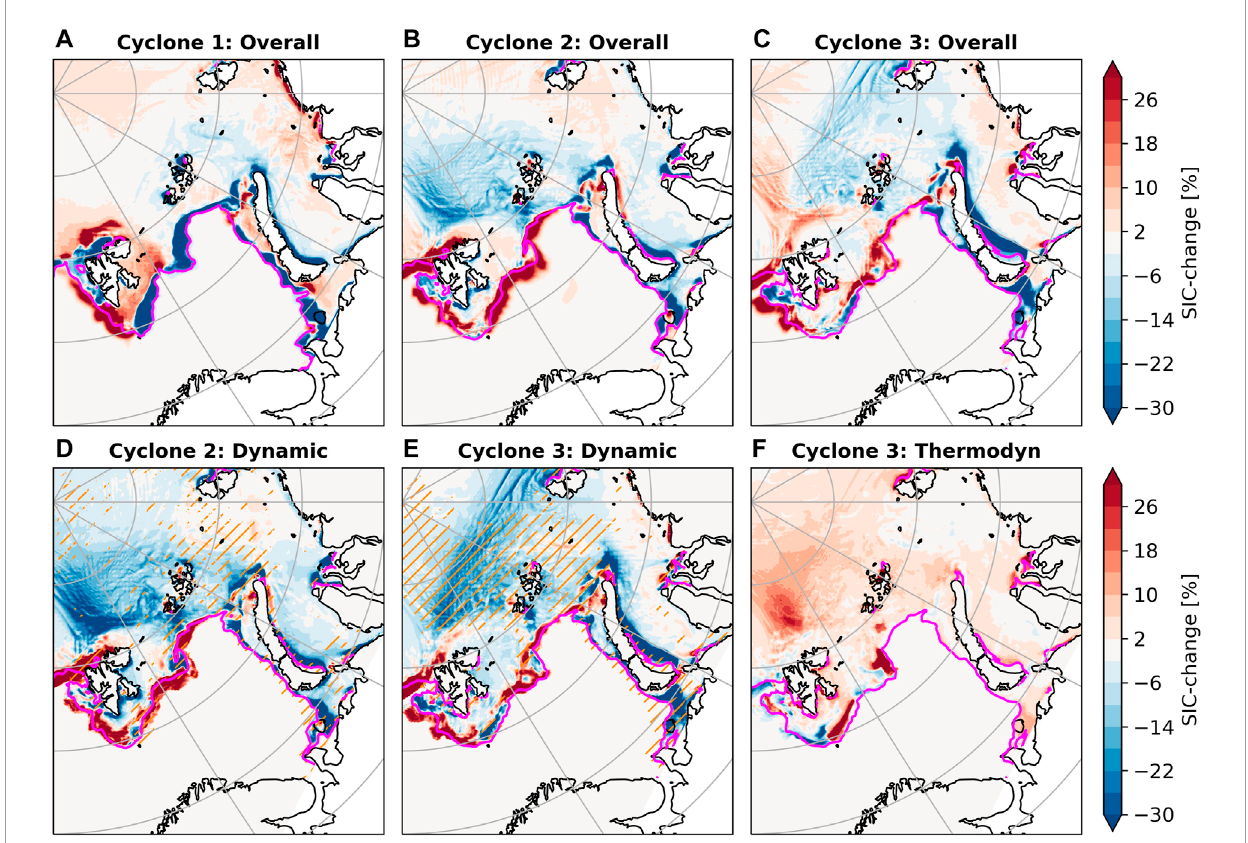
FIGURE 5 SIC change during cyclone 1 (9.2.—13.2.2020) (A) , cyclone 2 (15.2.—20.2.2020) (B) and cyclone 3 (20.2.—25.2.2020) (C) as well as temporally integrated dynamic SIC changes for cyclone 2 (D) and cyclone 3 (E) and temporally integrated thermodynamic SIC changes during cyclone 3 (F) . Orange hatching indicates grid-cells that have lost at least 5 cm of SIT during the previous cyclone passage(s). All based on the HIRHAM–NAOSIM simulation. Pink lines indicate the position of the ice edge (15% SIC) at the start of each cyclone passage.